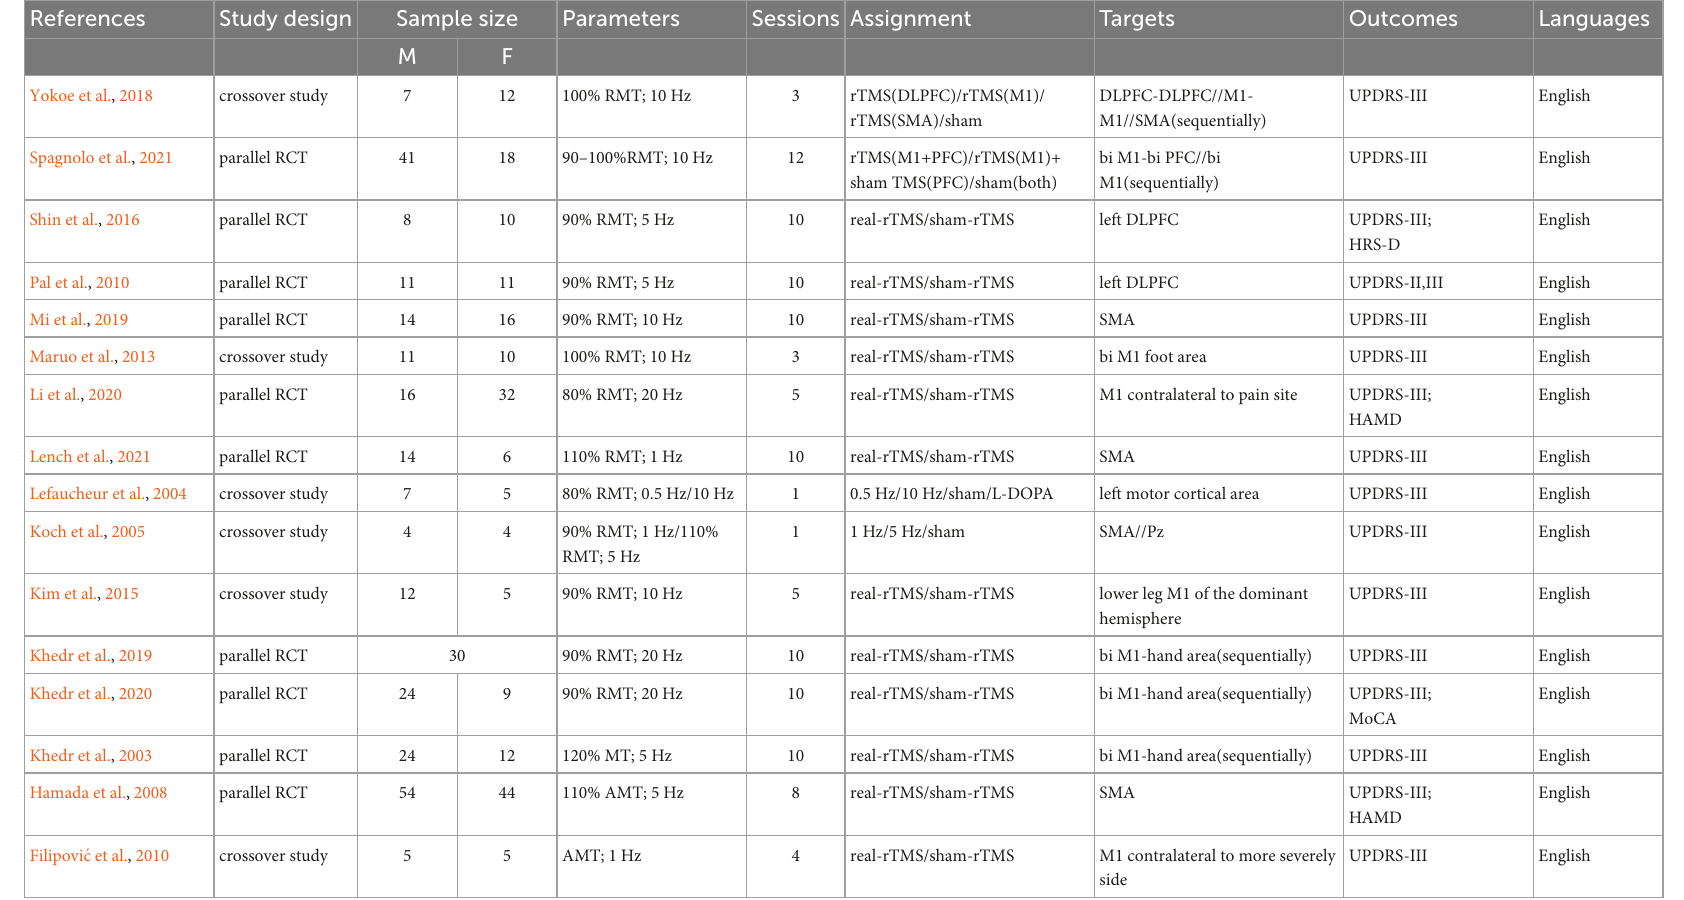
TABLE 1 The characteristics of included